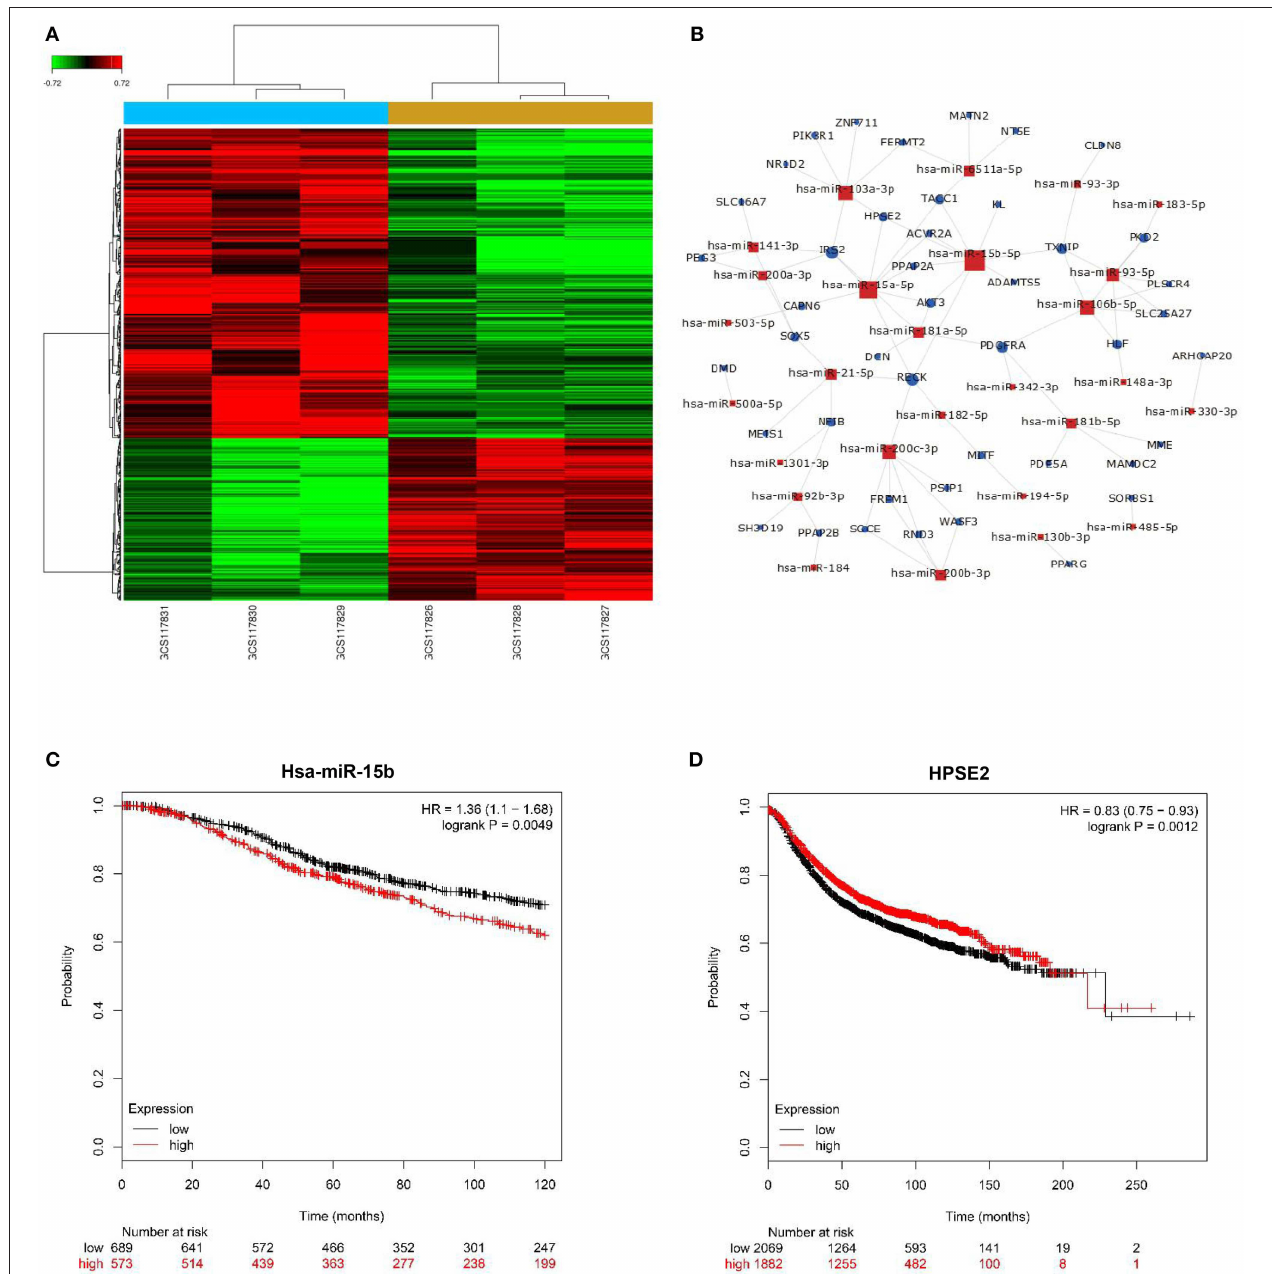
FIGURE 1 | miRNA expression profiling in three paired breast cancer and adjacent normal tissues. (A) The heatmap reveals clusters of differentially expressed miRNAs; green indicates relatively low expression, and red indicates relatively high expression. (B) miRNAs–gene network was constructed to illustrate the key regulatory functions of the identified miRNAs and their target genes. The size of the circle or square node represents the degree value. A higher degree of gene/miRNAs indicates that it plays a more important role in the signaling network. (C,D) Correlation of miR-15b-5p or HPSE2 with overall survival (OS) or relapse-free survival (RFS) of breast cancer patients. The data illustrated are from the Kaplan–Meier Plotter database (http://kmplot.com/analysis/).